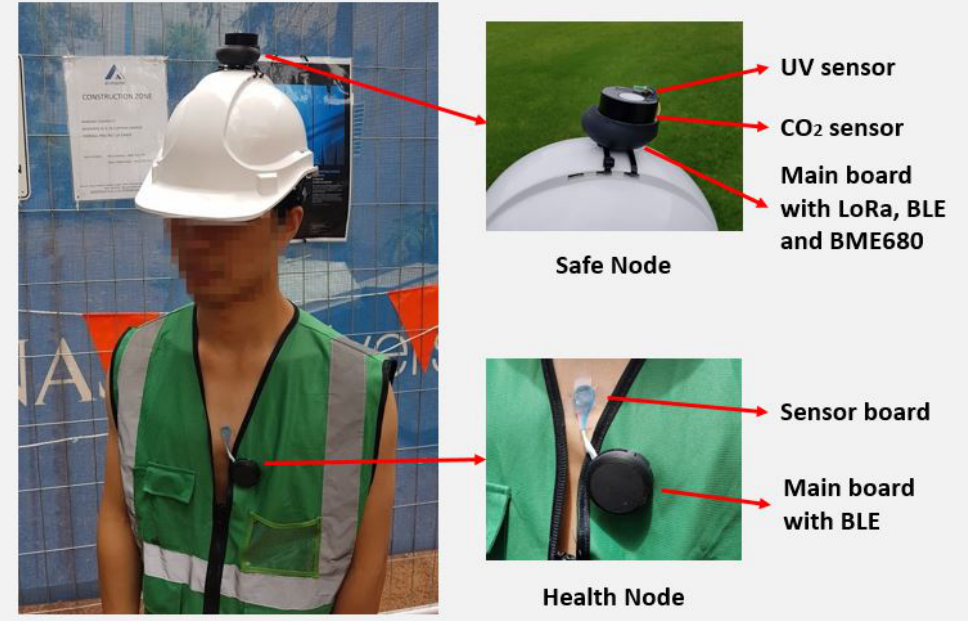
Figure 3. The Safe Node and Health Node are attached to the subject’ helmet and